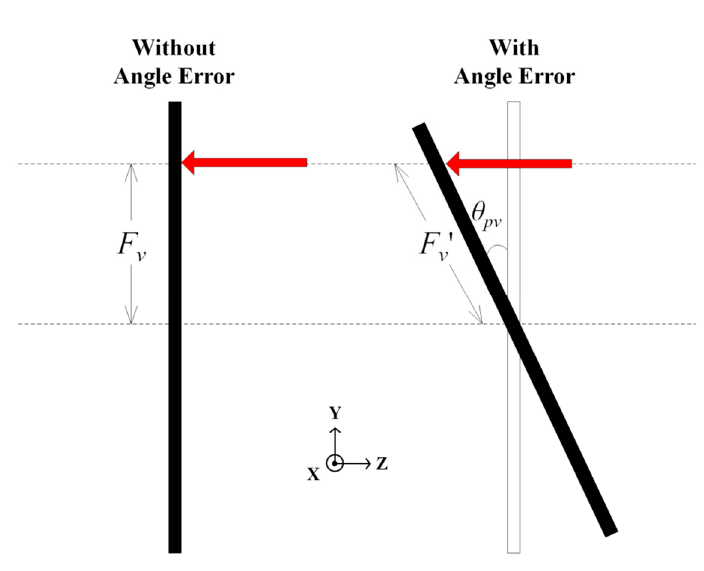
Figure 10. Position sensing detector (PSD) setup error. Table 2. Error analysis of the PSD setup .